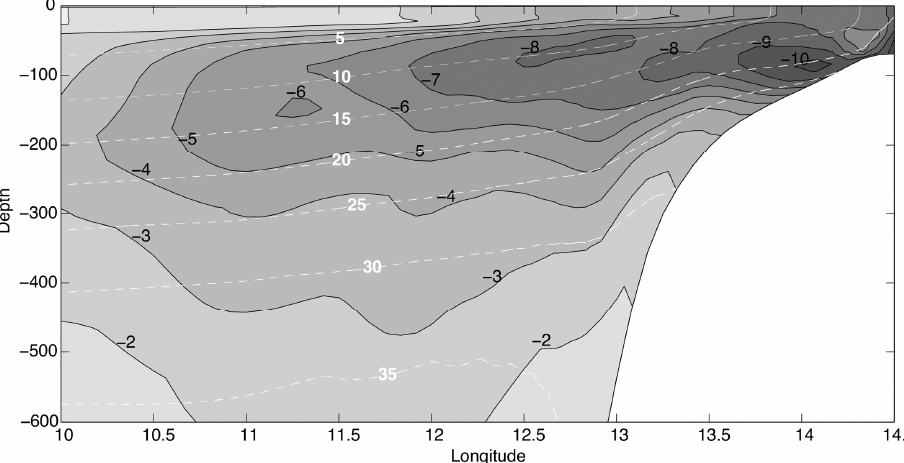
Fig. 7. Nitrate deficit (mmolNm − 3 ) between the eddy-resolving simulation and a non eddy-resolving simulation, featuring the role of eddies on vertical distribution of nutrients in the Benguela upwelling system. Dashed lines represent nitrate isocontours for the eddy-resolving simulation. The fields are averaged between 22 ◦ S and 24 ◦